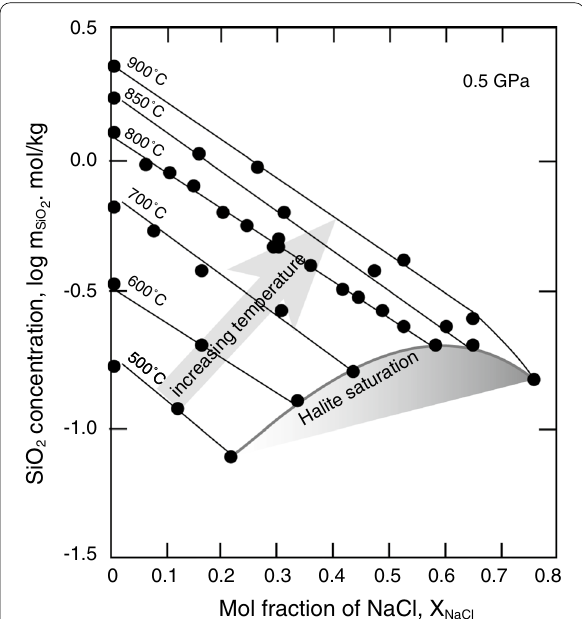
Fig. 13 Solubility of SiO 2 in H 2 O–NaCl fluid as a function of salinity at different temperatures as indicated and 0.5 GPa total pressure. Modified from Newton and Manning